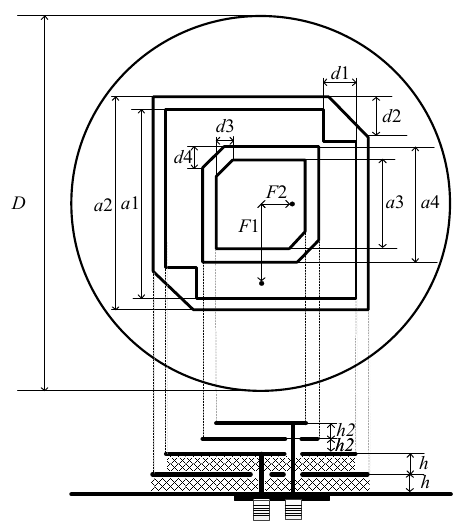
Fig. 1. Geometry of the combined Argos-3/GPS L1+L2 antenna.